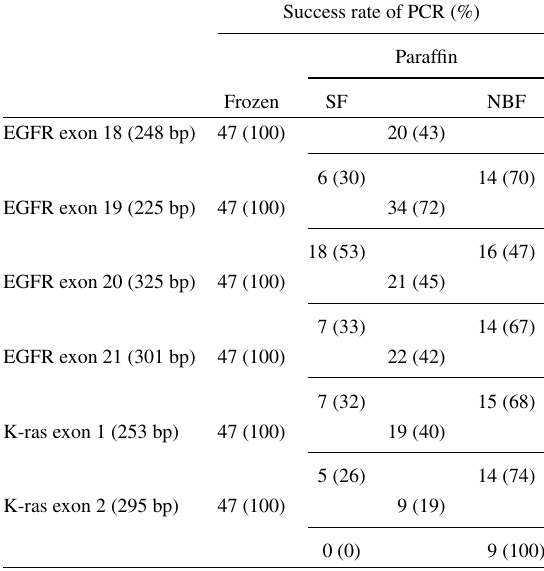
Success rate of PCR on DNA derived from frozen and sublimate for- malin or neutral buffered formalin fixed paraffin embedded NSCLC